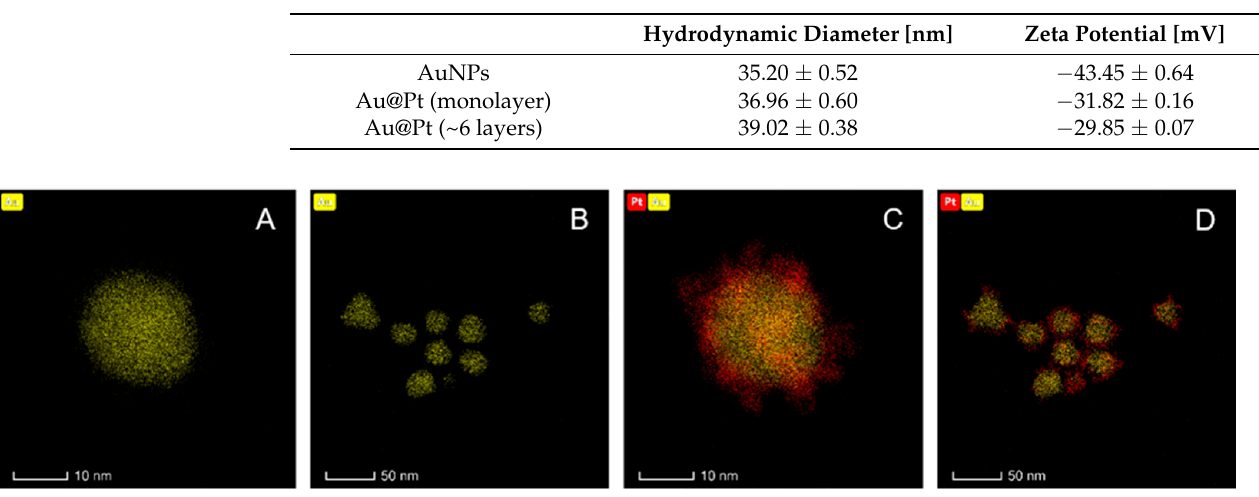
Figure 2. Digital image of synthesized AuNPs ( A ), Au@Pt–monolayer ( B ) and Au@Pt–multilayer